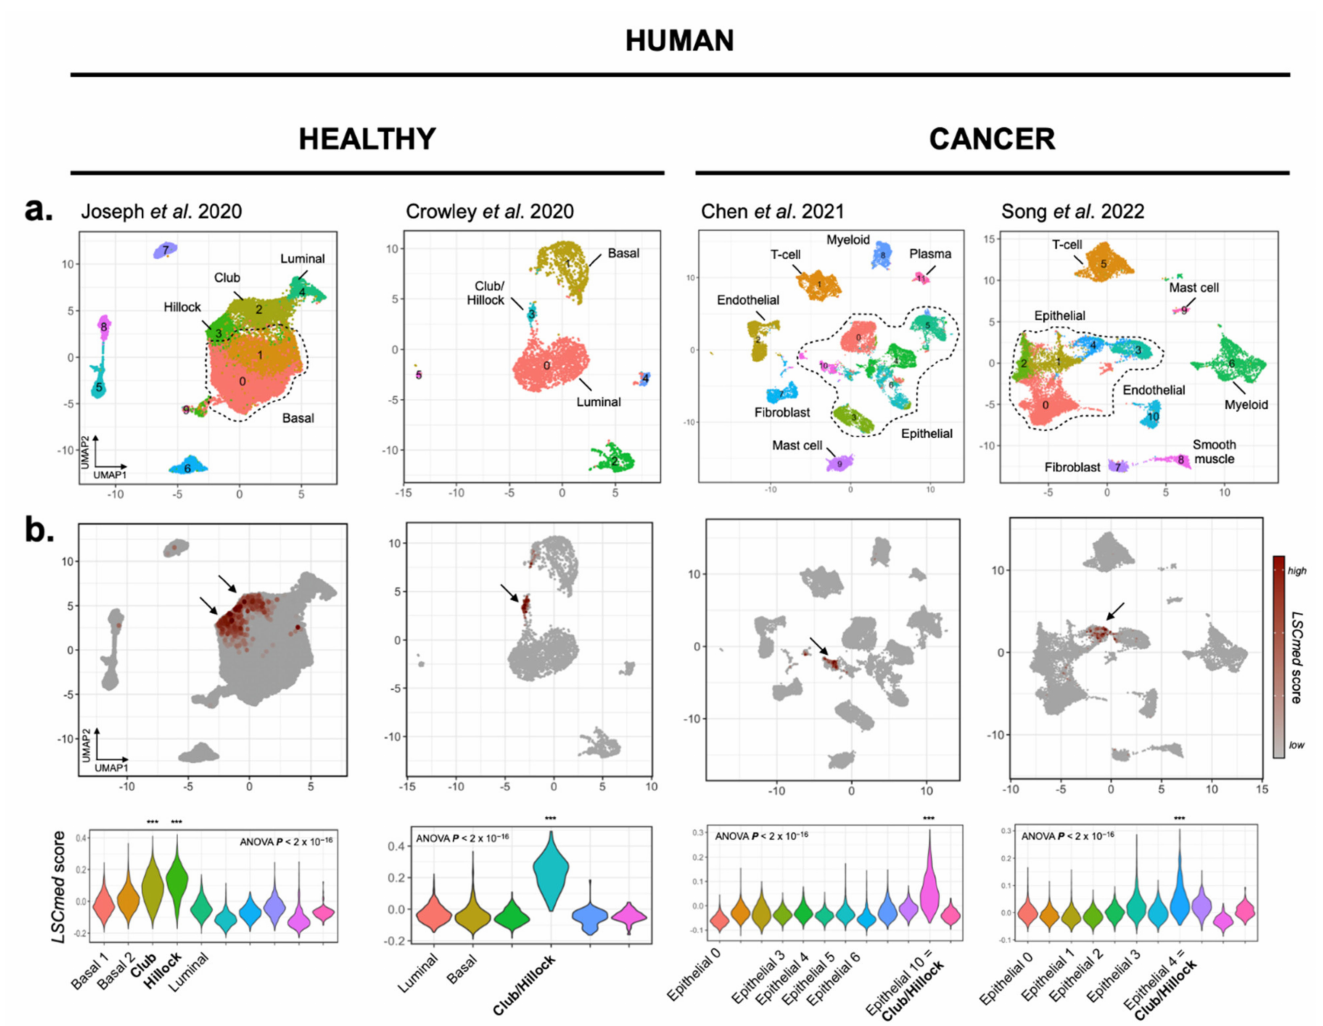
Figure 3. Transcriptomic similarity between FACS-enriched WT mouse LSC med cells and Club and Hillock cell clusters identified by scRNA-seq analyses of human healthy prostates and prostate cancer. ( a ) UMAP projections based on linear dimensionality reduction by principal component analysis (PCA) for 28,759 [17] and 3352 [16] healthy prostate single-cell transcriptomes, as well as 24,203 [20] and 14,937 [21] prostate cancer single-cell transcriptomes. Club and Hillock cells could be identified in the Joseph et al. dataset, but a single Club/Hillock cluster was identified in all other datasets. ( b ) In each study, only Club and/or Hillock cell subpopulations matched LSC med -like cells, as shown by high calculated LSC med gene signature scores. The violin plots show the calculated LSC med scores per cluster and per study (***, Tukey’s multiple comparisons of means P adj < 0.001 for all pairwise comparisons